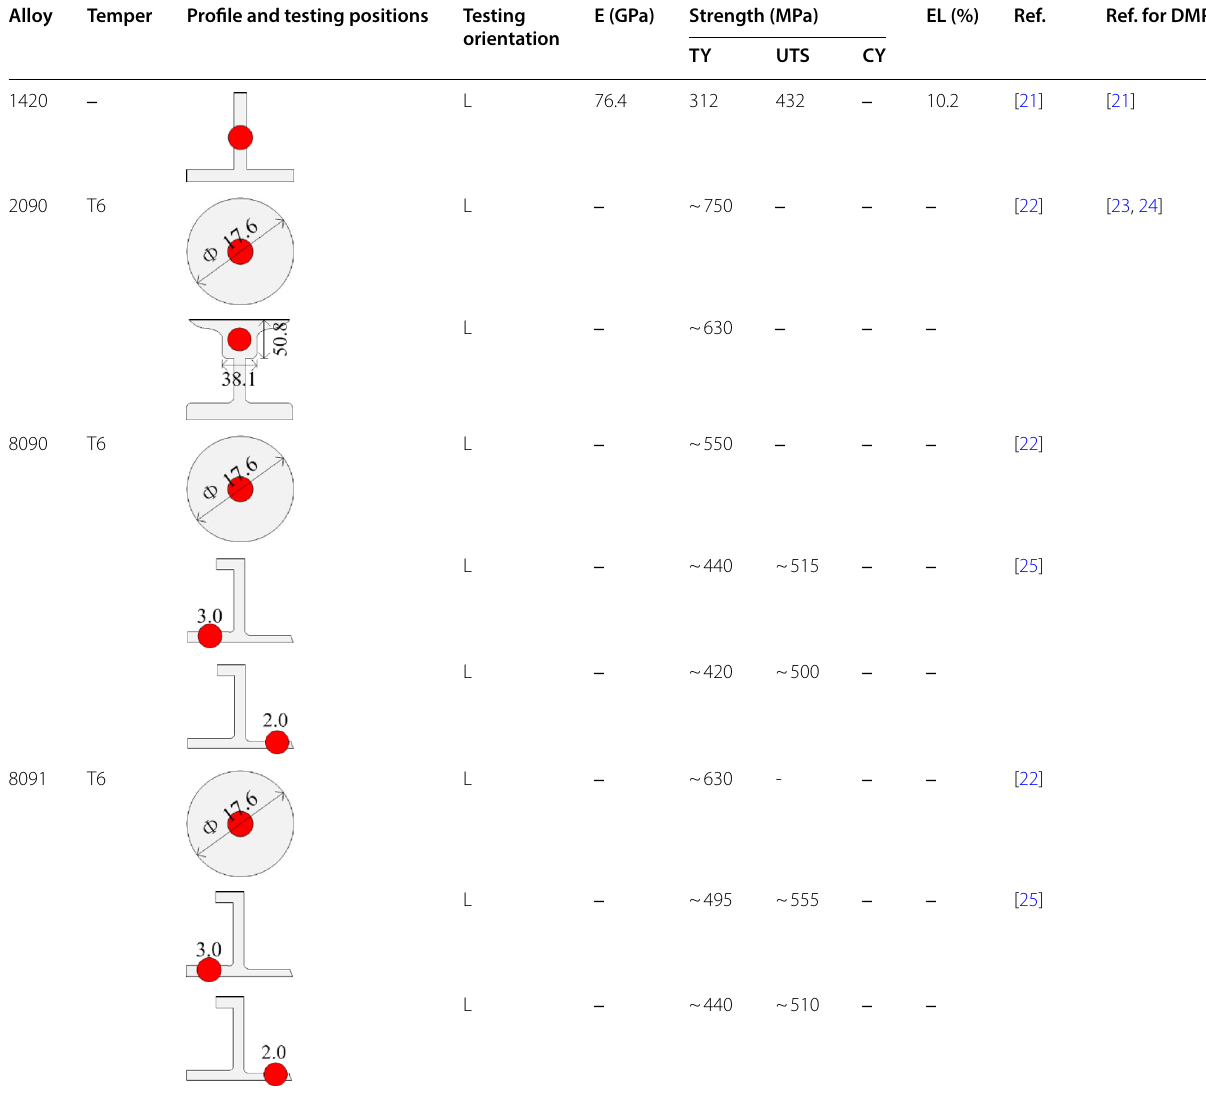
Table 2 Mechanical properties of Al–Li extrusion profiles Alloy